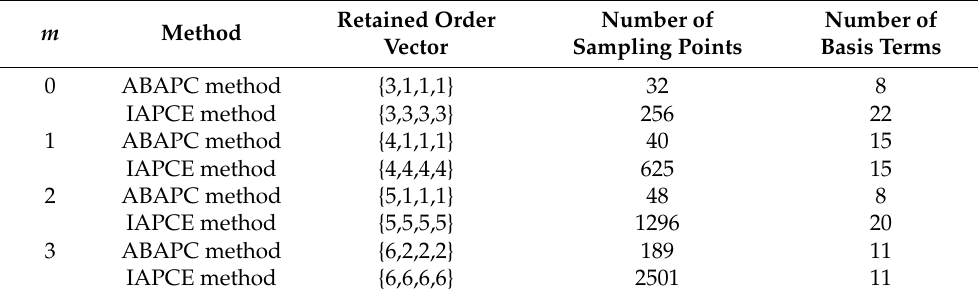
Table 2. Updated order vectors of the proposed method and IAPCE